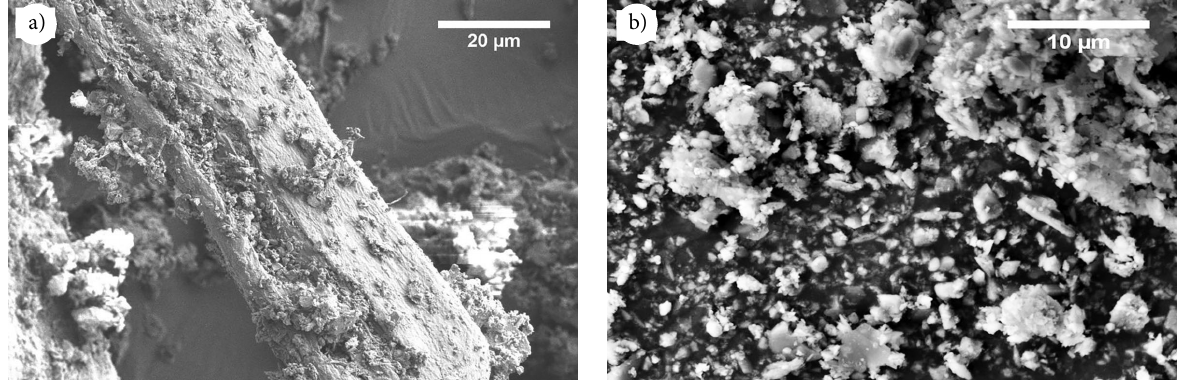
Fig. 1. SEM images of PWS particles: a) organic matter (magnification of × 2000); b) inorganic matter (magnification of × Table 3. Quantitative chemical composition of PWS particles Amount,